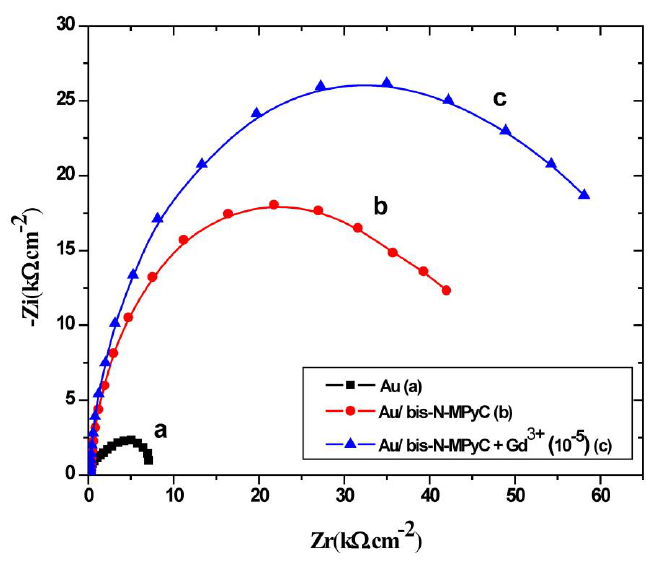
Figure 6. Nyquist diagrams at − 0.9 V/SCE polarization, in the frequency domain 0.1 Hz to 100 kHz, for bare gold electrode ( a ), bis-N-MPyC-functionalized gold electrode ( b ) and Gd 3+ -bis-N-MPyC- functionalized gold electrode ( c ). Measurement medium: 0.01 M aqueous ammonium acetate (CH 3 CO 2 − NH 4 + ) solution at pH